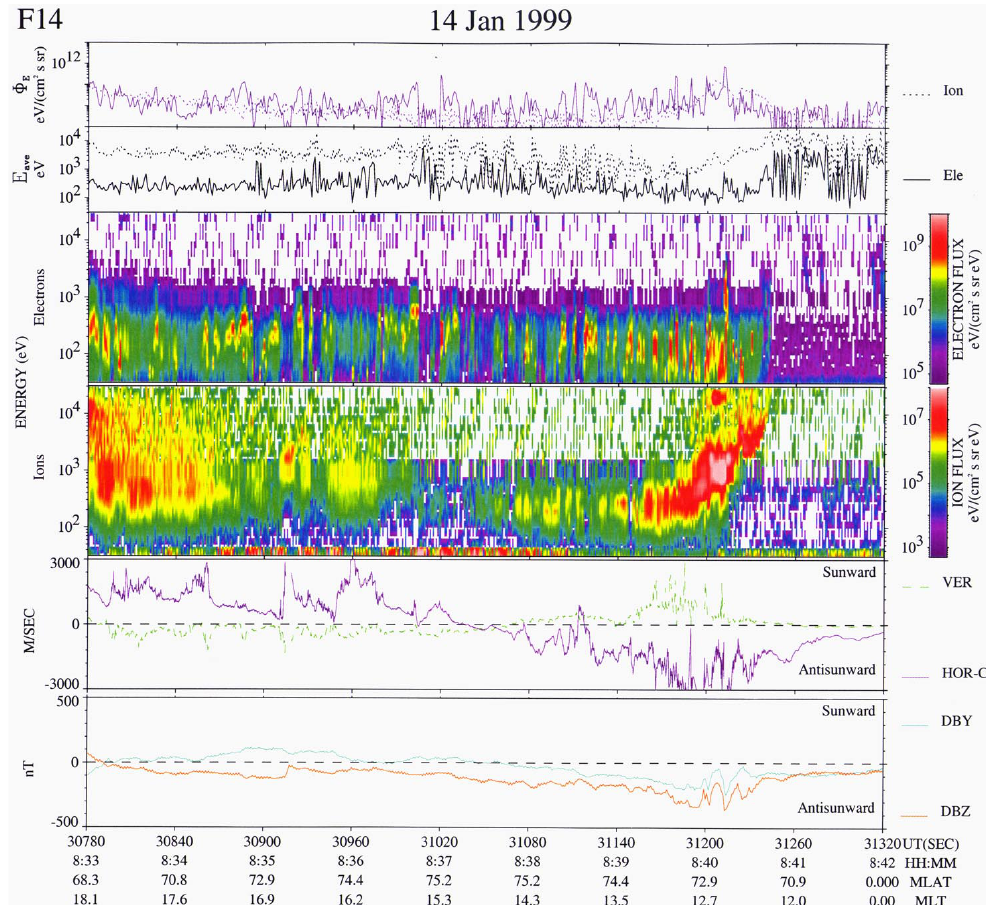
Fig. 13. Particle spectrograms, ionospheric ion drift and magnetic deflections obtained from spacecraft DMSP F14 during the interval 08:33– 08:42UT on 14 January 1999. Panels 1 and 2 show differential particle flux (electrons and ions) and average energy, respectively. Panels 3 and 4 show color-coded particle spectrograms for electrons and ions, respectively. Panel 5 shows ion drift in the horizontal (cross track; violet) and vertical (upward; green) directions. Panel 6 shows the horizontal magnetic field deflection components along ( DB Y ) and normal ( DB Z ) to the satellite